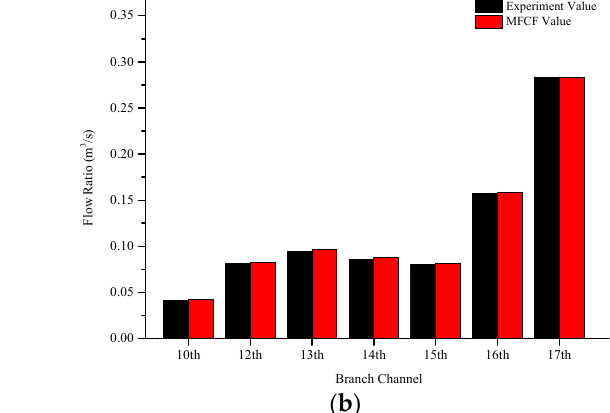
Figure 9. The relationship between the experimental results of the flow rate and the results of the modified flow calculation formula: ( a ) the 1st to 9th branches; ( b ) the 10th to 17th branches. “WMSCF” represents the water measurement specification calculation formula, and “MFCF” represents the modified flow calculation formula.